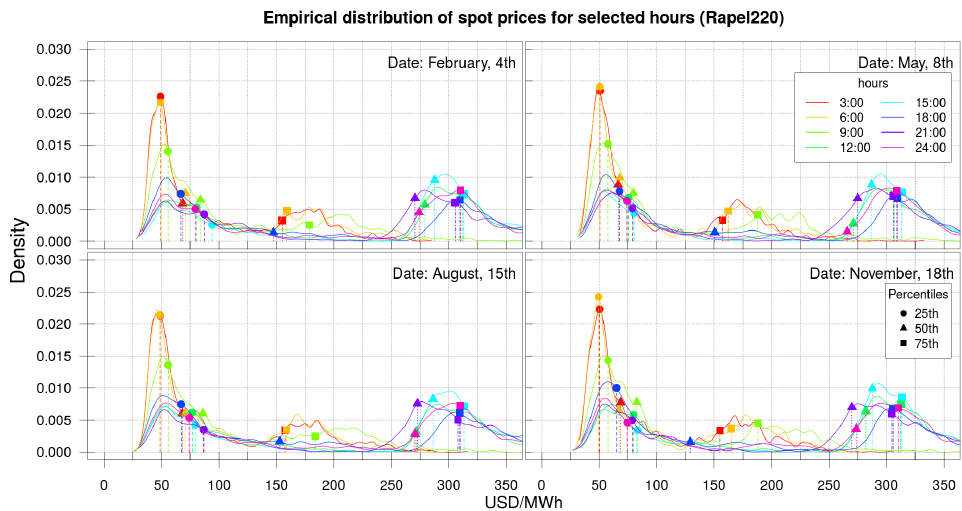
Figure 7. Empirical density distribution spot prices for Rapel220 in four representative days of the year.